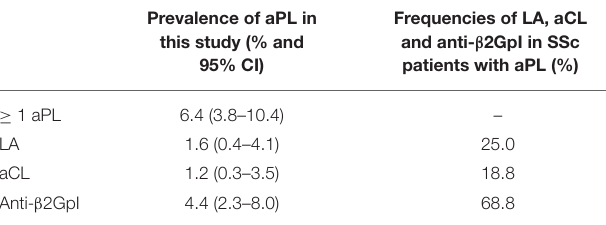
TABLE 3 | Univariate and multivariate comparisons of associations between aPL TABLE 2 | Prevalence of aPL in this cross-sectional SSc study and frequencies of positivity in SSc patients and clinical manifestations. LA, aCL, and anti- β 2GpI in SSc patients with aPL ( n = 249, single testing). p Multivariate Univariate Prevalence of aPL in Frequencies of LA, aCL OR (95% CI) OR (95% this study (% and and anti- β 2GpI in SSc